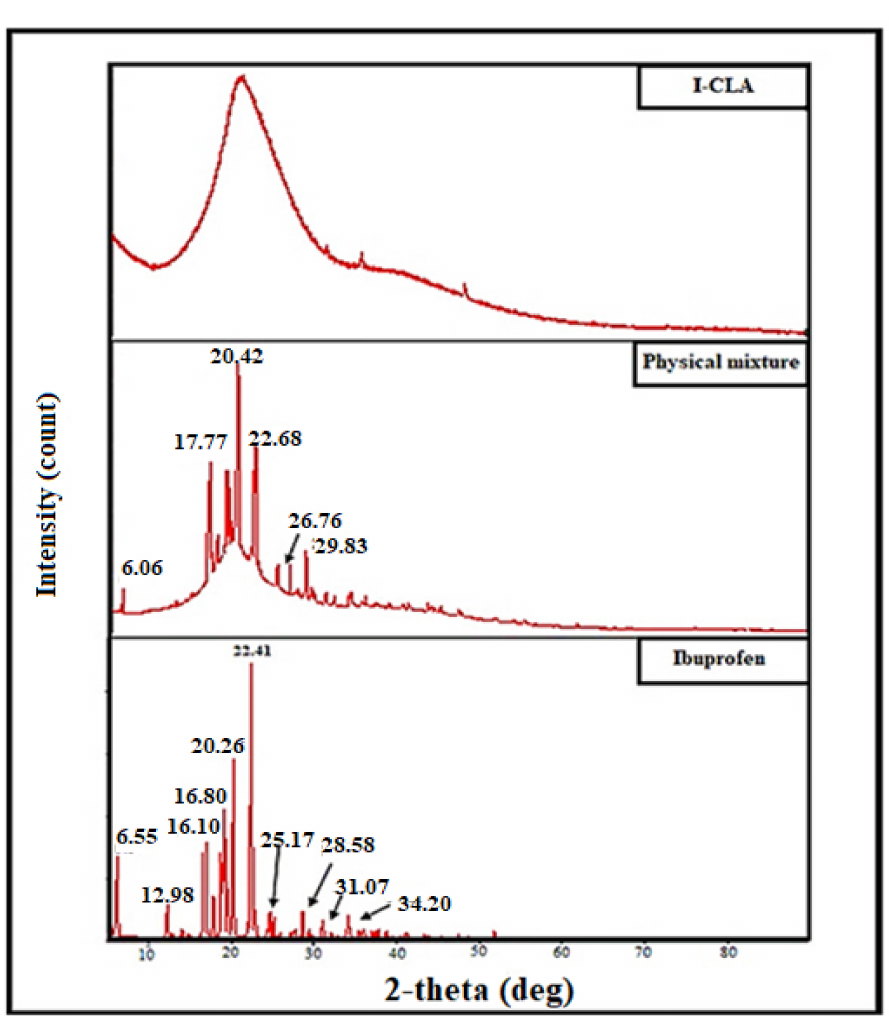
Figure 5. XRD patterns of pure ibuprofen powder, physical mixture, and IBU-loaded chitosan–PC90G with gum arabic (I-CLA).